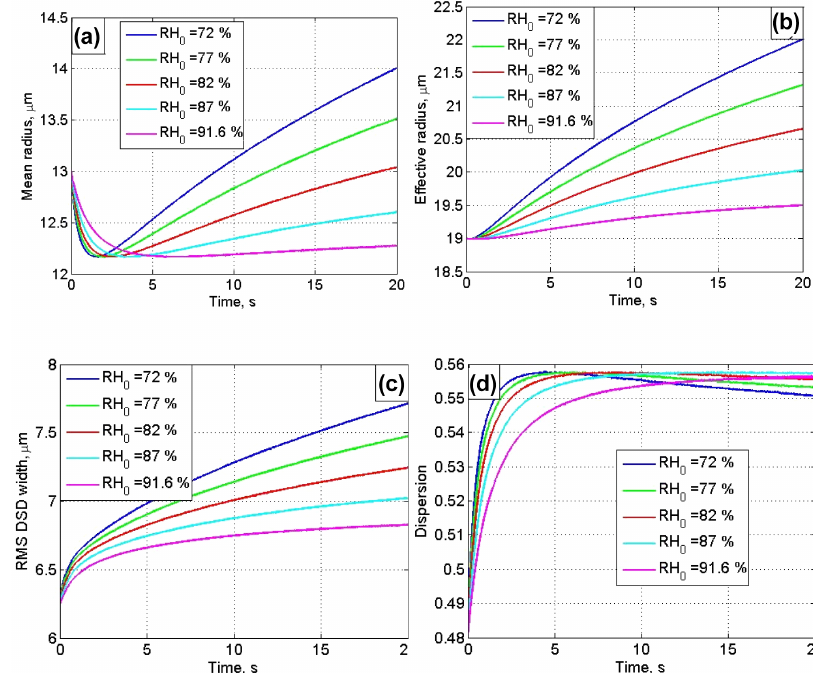
Figure 10. The same as in Fig. 9 but for an initially wide